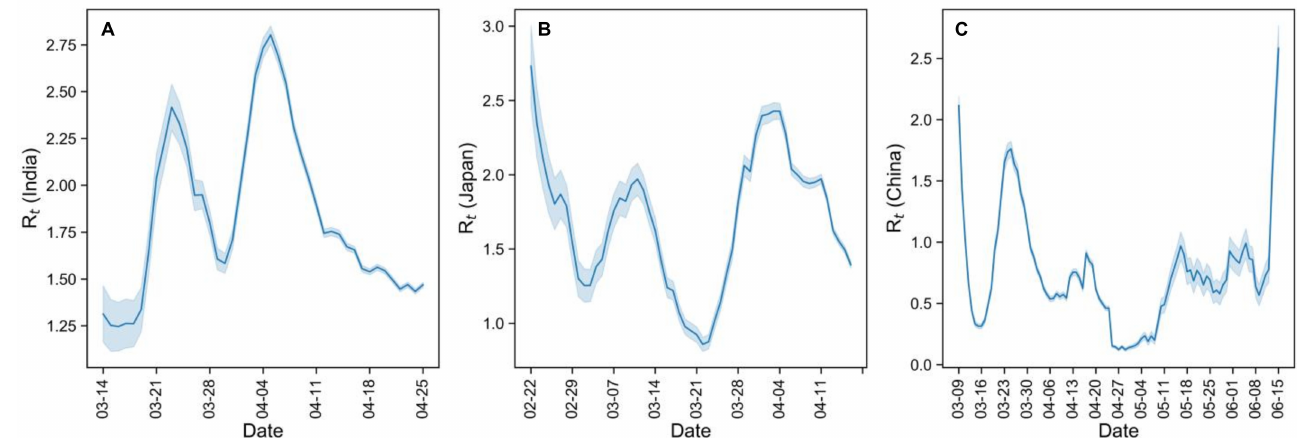
Figure 1. Time-varying reproductive number R t in ( A ) India, ( B ) Japan and ( C ) China using R package, EpiEstim ; parameter settings are described in Section 2.2. Note that the R t in China was generally less than 1 despite ongoing virus spread.